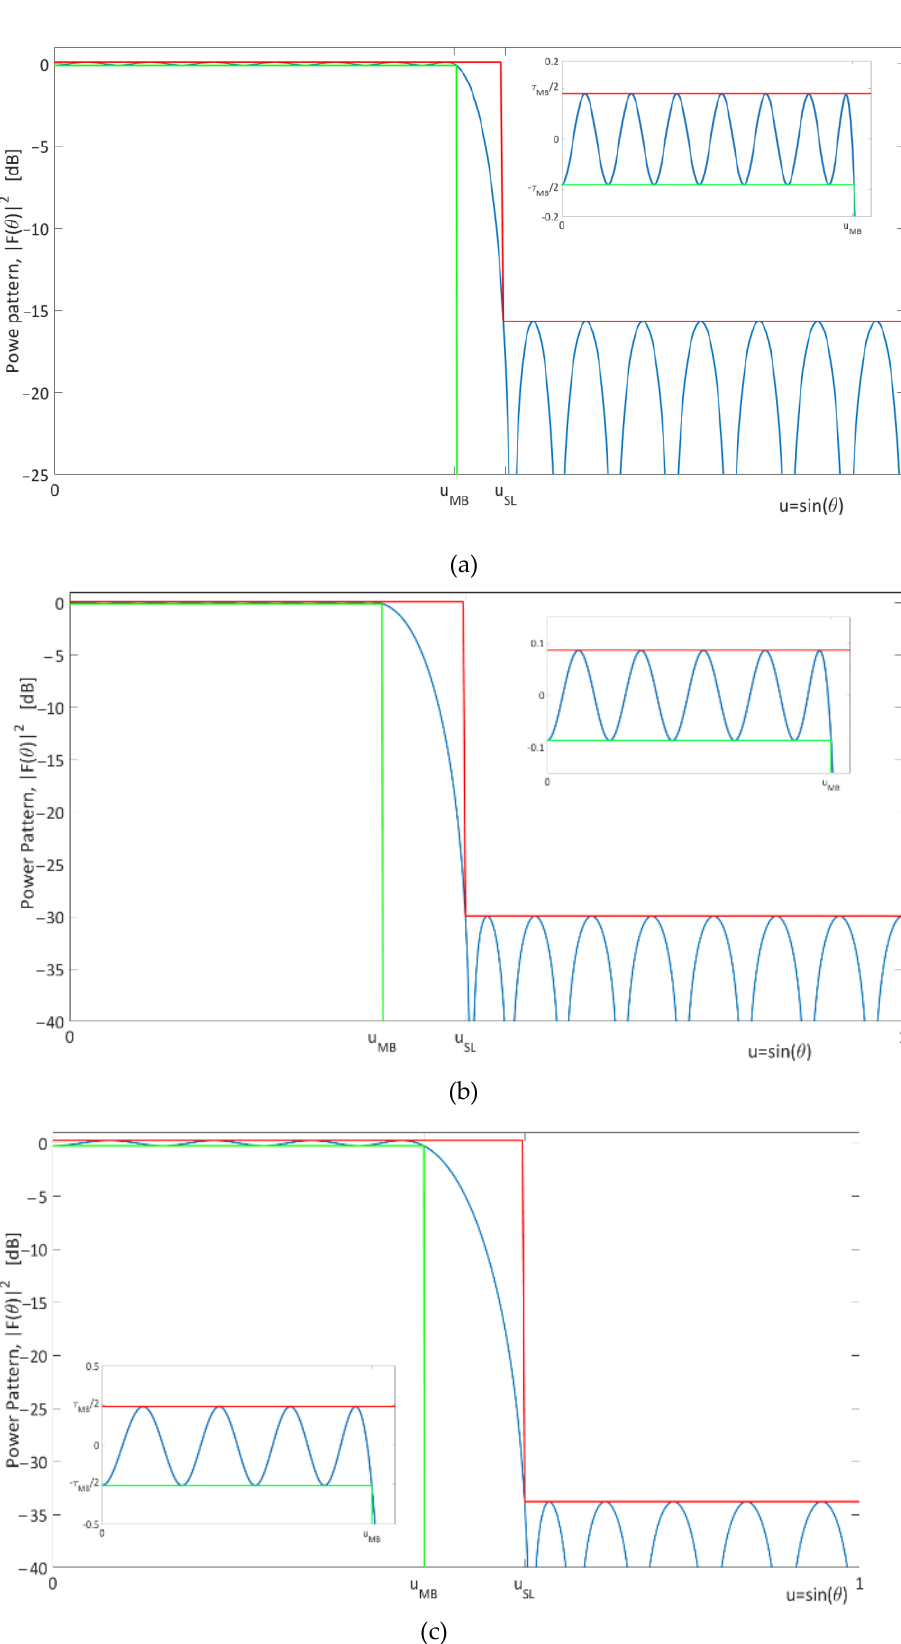
Figure 10. The radiation patterns synthesized with the linear programming for the examples in ( a ) Section 4.1, ( b ) Section 4.2, and ( c ) Section 4.3. All of the patterns satisfy the imposed